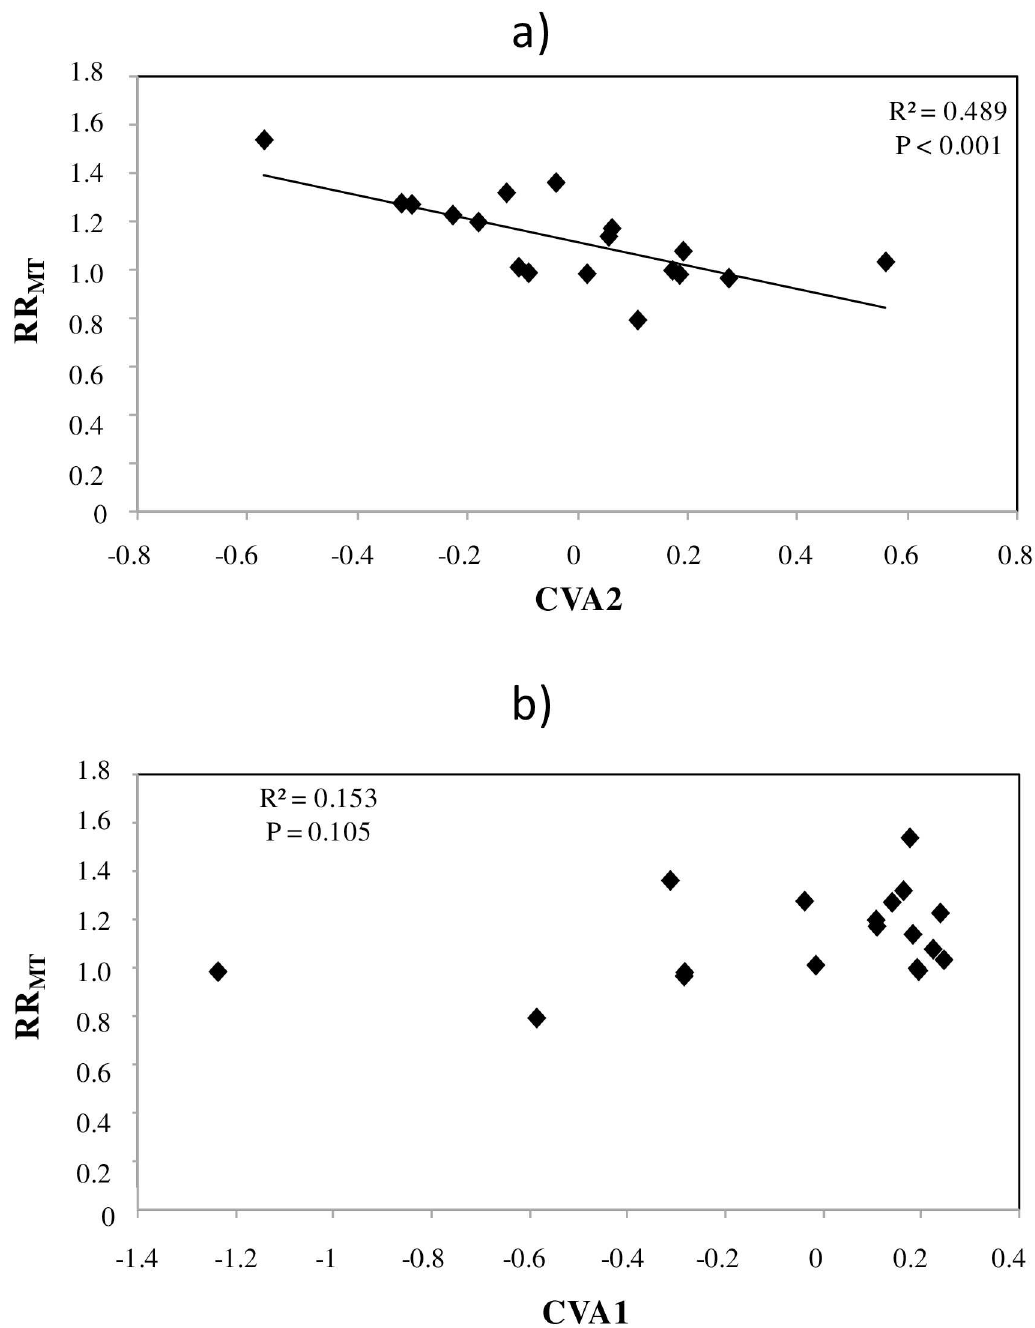
Fig 1. Linear regressions between a) RR MT and CVA1 or b) CVA2. Black diamonds represent each soil (n =